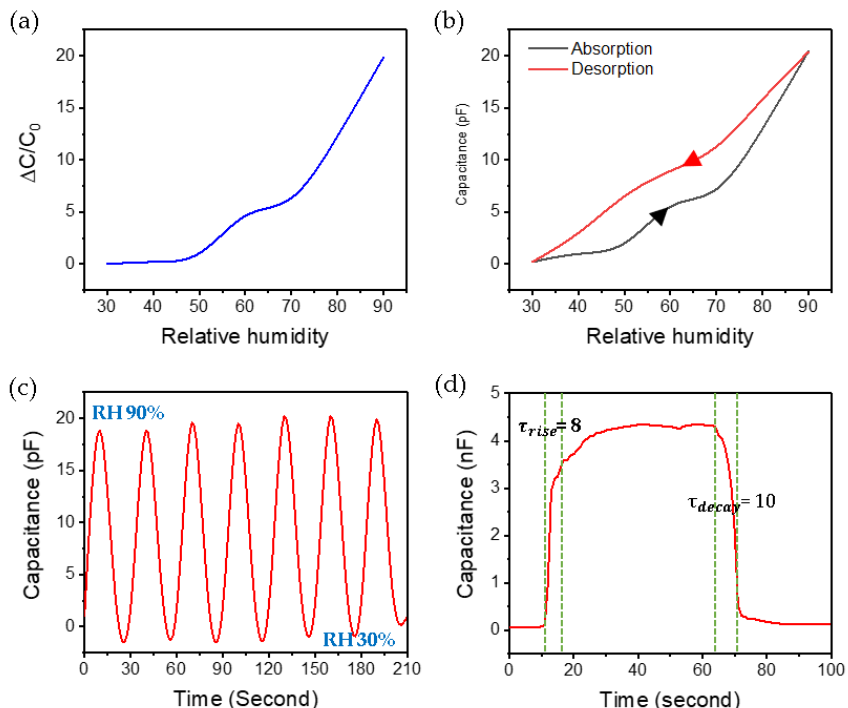
Figure 7. ( a ) Measurement of capacitance change according to relative humidity 30% to 90%, ( b ) hysteresis characteristics of the humidity sensor, ( c ) cycling stability test of the humidity sensor, ( d ) capacitance-time curve of the sensor from 30% to moisture saturation.